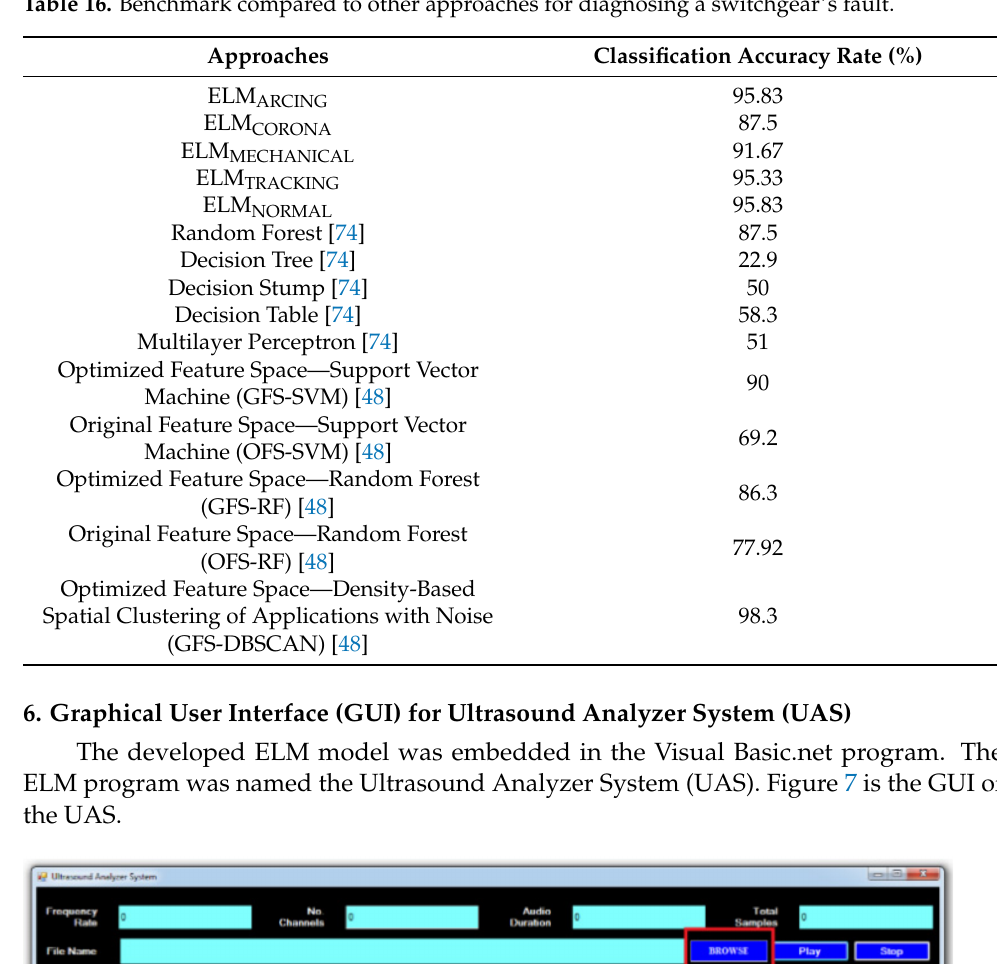
Table 16. Benchmark compared to other approaches for diagnosing a switchgear’s fault.